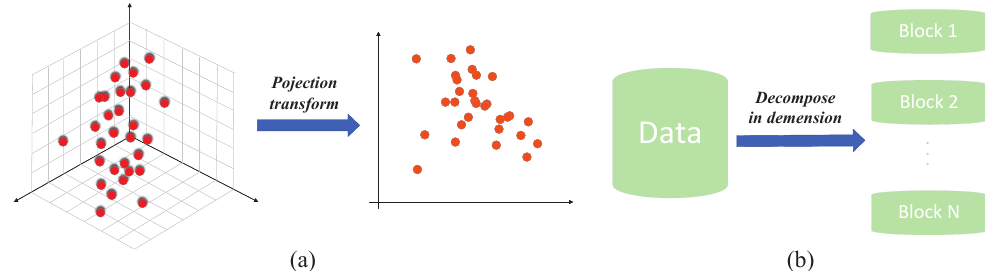
Figure 1. Schematic diagram of the two process monitoring methods for high-dimensional data. ( a ) Projected methods; ( b ) Distributed learning